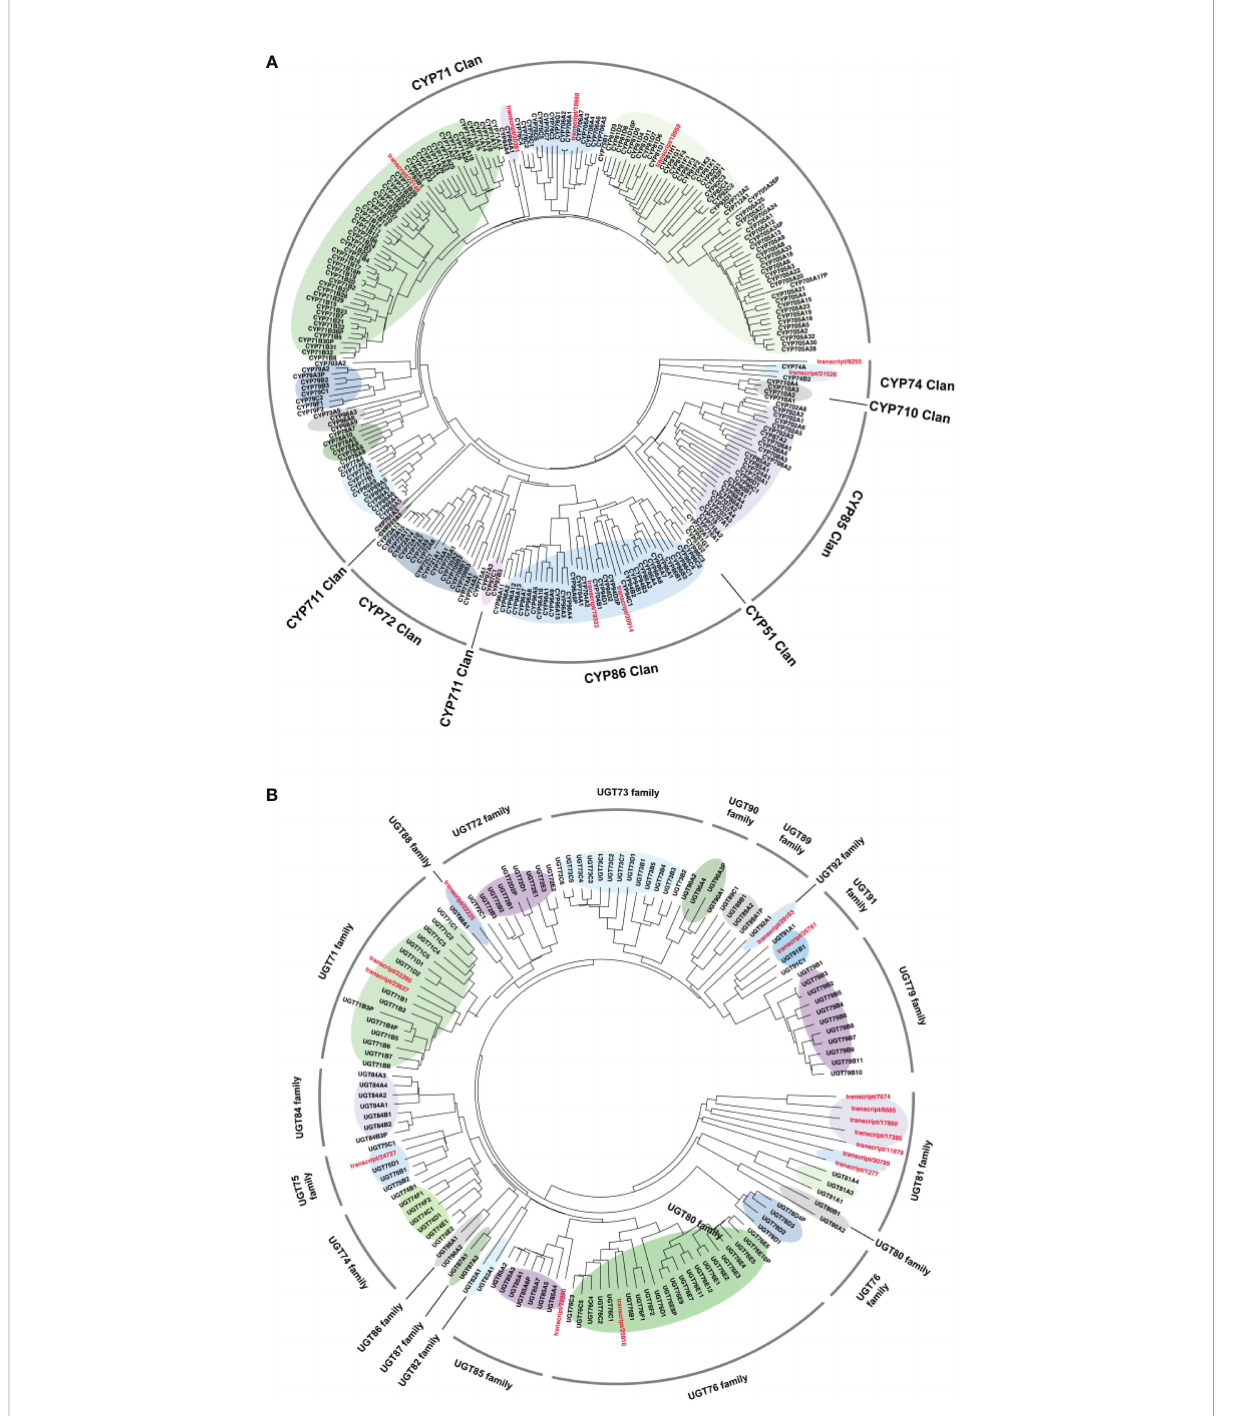
FIGURE 9 Phylogenetic tree of candidate genes with the representative. (A) CYP450 and (B) UGT family members. MEGAX software was used to align amino acid sequences of target genes and draw the Neighbor-Joining